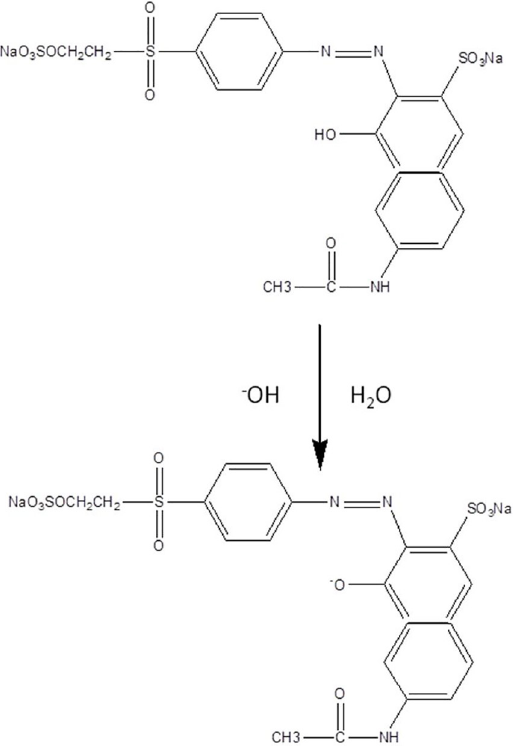
Figure 6. RO16 dye protonated/deprotonated